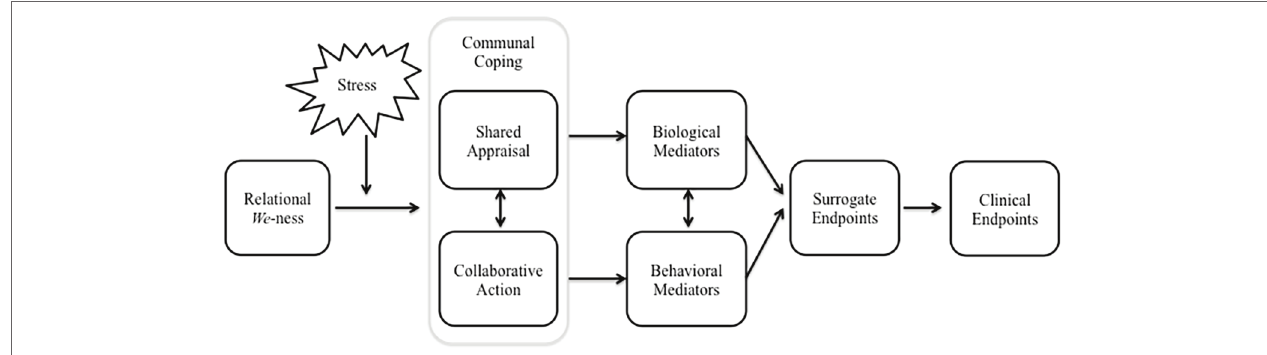
FIGURE 1 | Conceptual model depicting potential pathways through which communal coping may affect